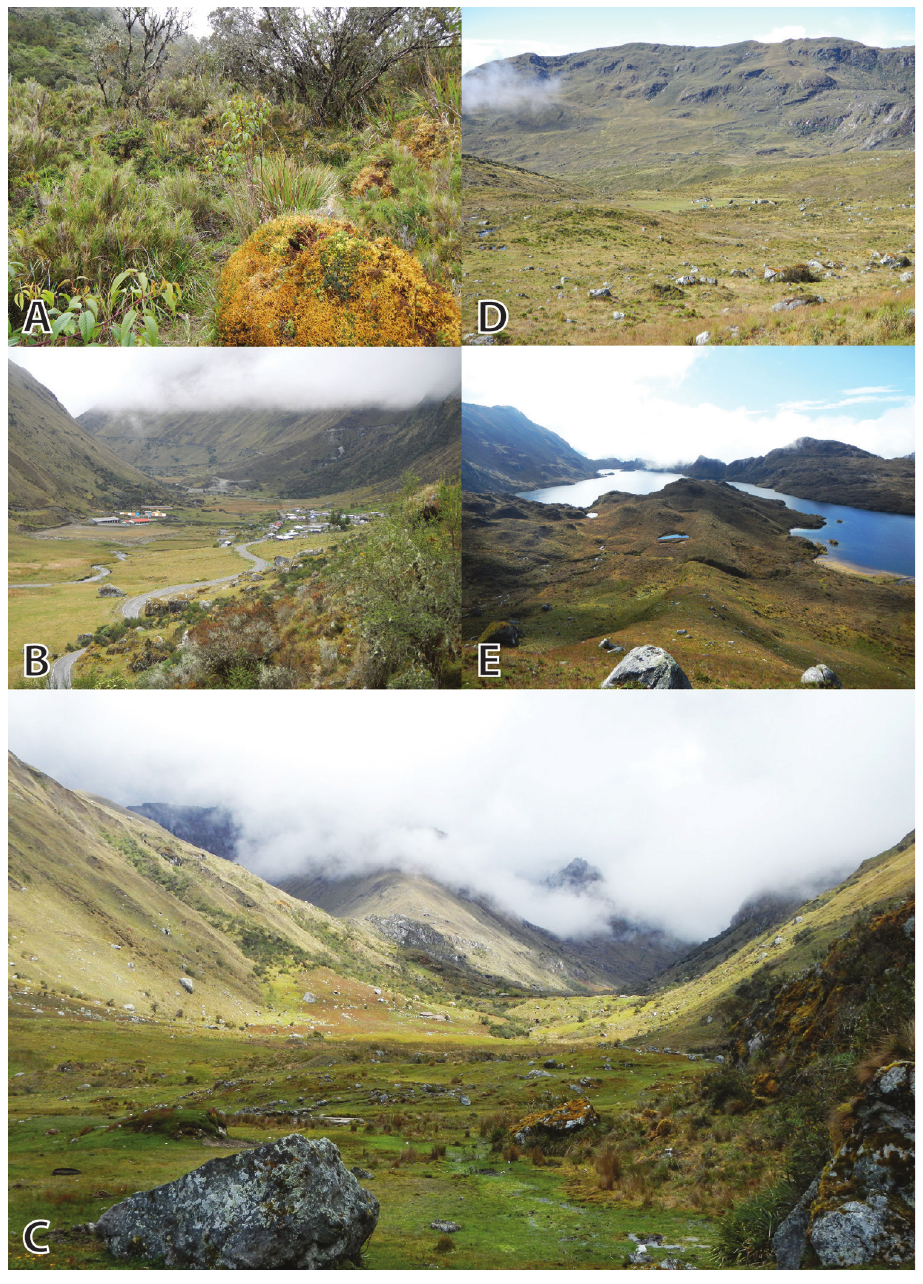
Figure 10. Type locality and habitats of Phrynopus inti sp. n. Satipo-Toldopampa Road at km 134 on left side of street coming from Satipo, 3350 m a.s.l., 23 June 2013 ( A ); Quebrada Toldopampa, 3670 m a.s.l., 22 June 2013 ( B ); Type locality, Quebrada Tasta, 3609 m a.s.l., 20 May 2012 ( C ) ; Antuyo, PPPF, 3700 m a.s.l., 27 June 2013 ( D ); Laguna Sinchon, PPPF, 3890 m a.s.l., 29 June 2013 ( E ). Photos by E.